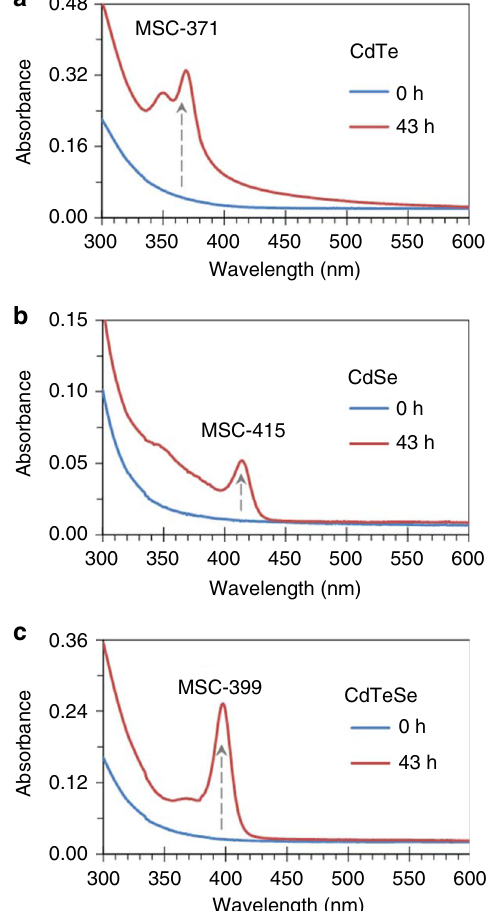
Fig. 2 Evolution of binary and ternary alloy MSCs. Optical absorption spectra of the induction period samples of binary CdTe ( a ) and CdSe ( b ), and their mixture ( c ) are collected before (blue traces) and after a 43-h incubation (red traces) at room temperature. The CdTe and CdSe samples were heated at 130 and 140 °C for 30 min, respectively; they were cooled to room temperature and mixed with equal volumes. An aliquot of each sample (30 μ L) was dispersed in toluene (3.0 mL) for the measurement. During incubation, evidently, CdTe MSC-371 and CdSe MSC-415 evolved from the corresponding binary samples, while only CdTeSe MSC-399 evolved from